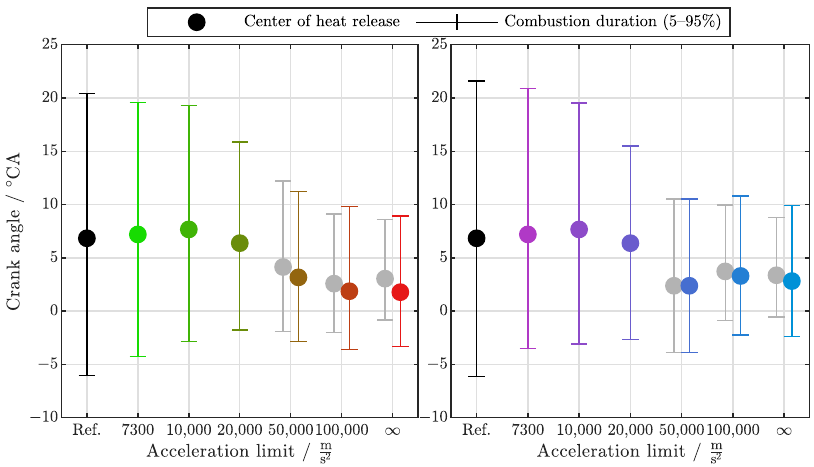
Figure 13. Timings for 5%, 50% and 95% of combusted fuel for the optimized piston trajectories at full ( left ) and part ( right ) load operation for different maximum piston acceleration